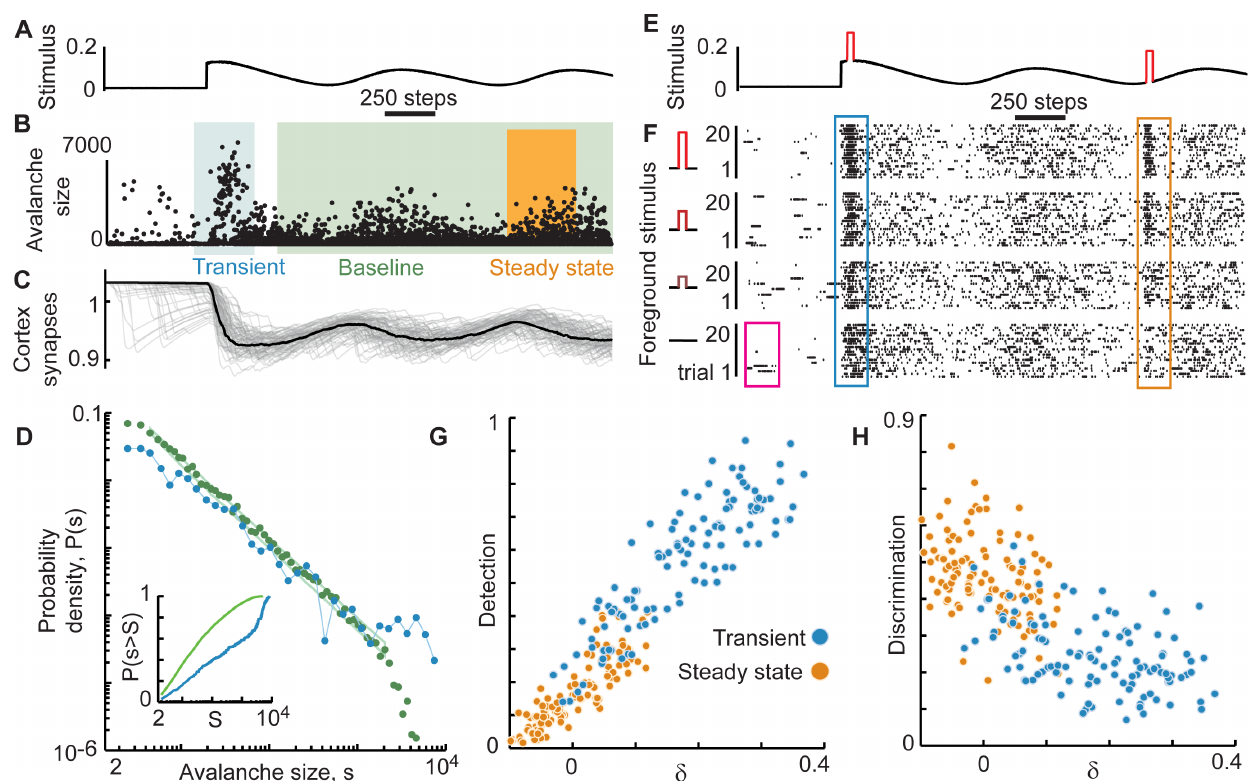
Fig 6. A network model with short-term depression reproduces the discrimination-detection trade-off. ( A ) The model network is driven by a slowly varying ‘background’ stimulus that turns on at t = 500 timesteps. We interpret 1 time step to be approximately 1 ms. ( B ) Avalanches with a tendencyfor very large sizes occur duringthe transient followingstimulus onset (blue). Smaller avalanches occur duringthe baseline period(green), which includesthe later time periodlabeled‘steady-state’ (orange). Avalanches are overlaid from 80 repetitionsof the same background stimulus. ( C ) Synapsestrength (averagedover all except the input synapses) drops at stimulus onset and fluctuates due to short term depression. Gray lines indicate singletrials (n = 80); black line is the cross-trial average. ( D ) Avalanches are distributedaccordingto a power-law duringthe baseline(green) and have a high likelihoodof very large avalanches duringthe transient (blue). Inset: cumulative distributions of the same data reveal that δ> 0 for the transient. ( E ) A ‘foreground’ stimulus (red) is appliedat two times: duringthe transient and later duringthe steady-state. ( F ) Raster of model spikes (from all neurons, subsampled) including 80 trials, brokeninto four blocks of 20, each with a different intensity of foreground stimulus. Responsewas definedas the spike count duringthe transient (blue) or the steady-state (orange). ( G, H ) Consistent with our experiments, discrimination of foregroundstimuli was inverselyproportional to δ whiledetection was proportional to δ .